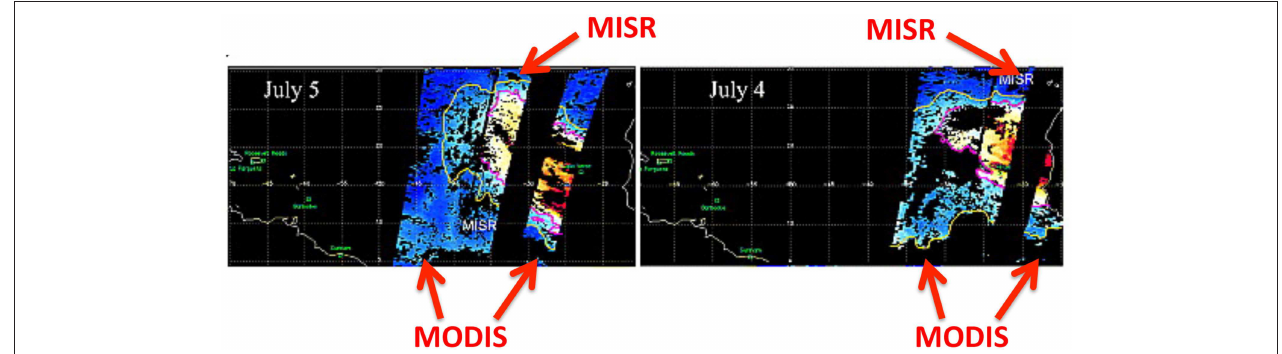
FIGURE 1 | Complementary MISR and MODIS coverage over dust plumes transported over the Atlantic. The narrower MISR swath partly fills in areas that would otherwise be lost to sun glint masking in the broader MODIS swath. MODIS AOD data (right and left of the MISR swath) is plotted together with the narrower MISR swath for two successive days in this dust plume event. AOD data in the middle of the MODIS swath is missing because of glint masking. MISR can retrieve AOD despite glint because only 2–3 out of nine MISR cameras view the scene in glint while other cameras point at the same scene, but at non-glint angles. These can be used for retrievals. Adapted with permission from Kalashnikova and Kahn (2008), John Wiley &